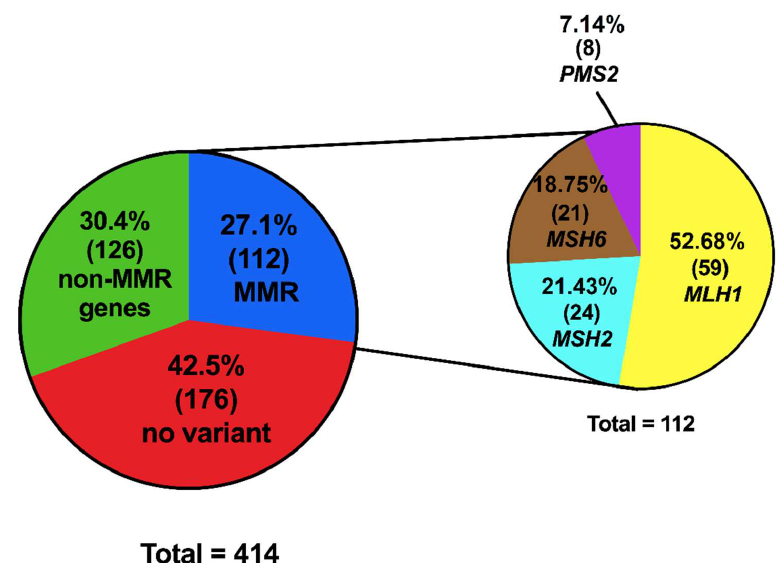
Commented [M1]: We highlighted all changes in main text and changed ratios in the right pie chart of Figure 2. If total number changed from 111 to 112, ratios should be changed accordingly. Now the total ratios sum up as 100%. Please check.